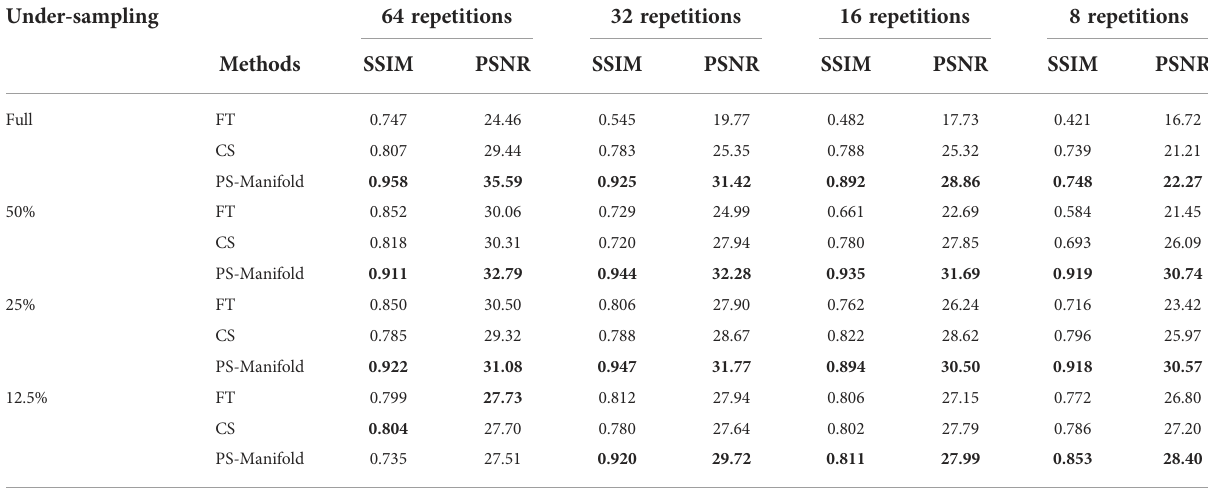
TABLE 3 Quantitative comparisons of FT, CS, and patient-speci fi c manifold methods with different undersampling ratios and noise levels in the experimental case. . Under-sampling 64 repetitions 32 repetitions 16 repetitions 8 repetitions